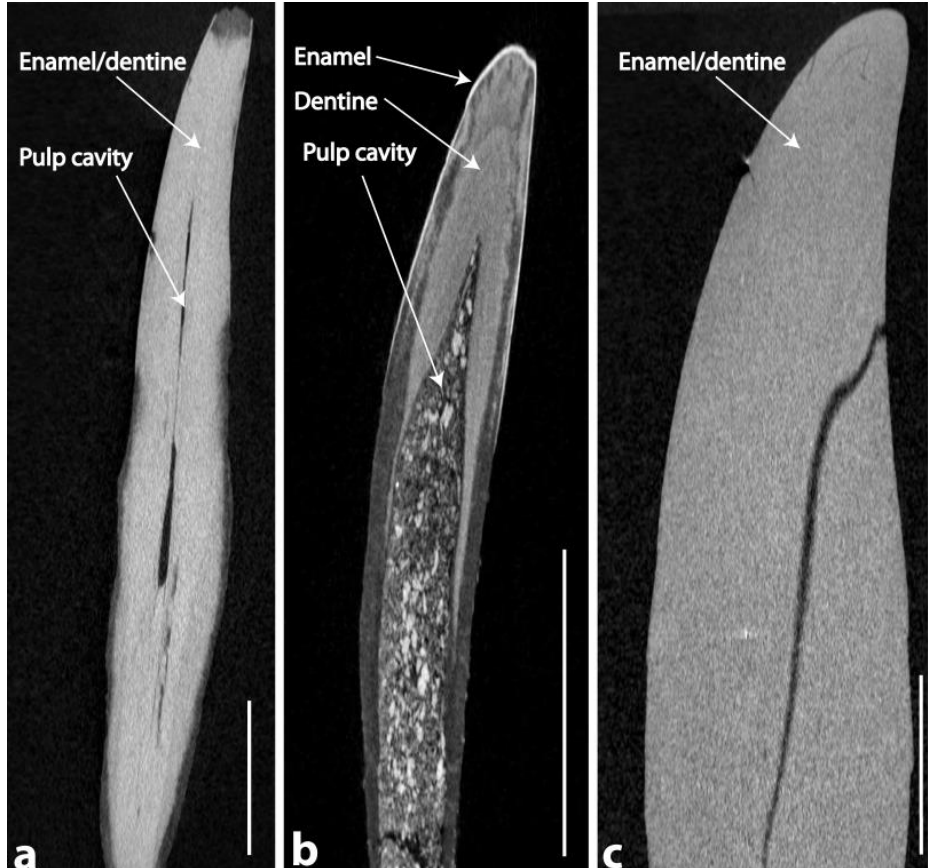
Fig. 3. Internal morphology of fossil odontocete teeth revealed by Micro-CT. Note the poor resolution of dentine and enamel-dentine junction in two of the specimens (a, c) and the different stages of obliteration of the pulp cavity. Scale bar = 5 mm. a) Squalodelphinidae, unnamed sp. (OU 22306). b) Delphinoidea, unnamed sp . 2 (OU 22108). c) Delphinoidea, unnamed sp. 1